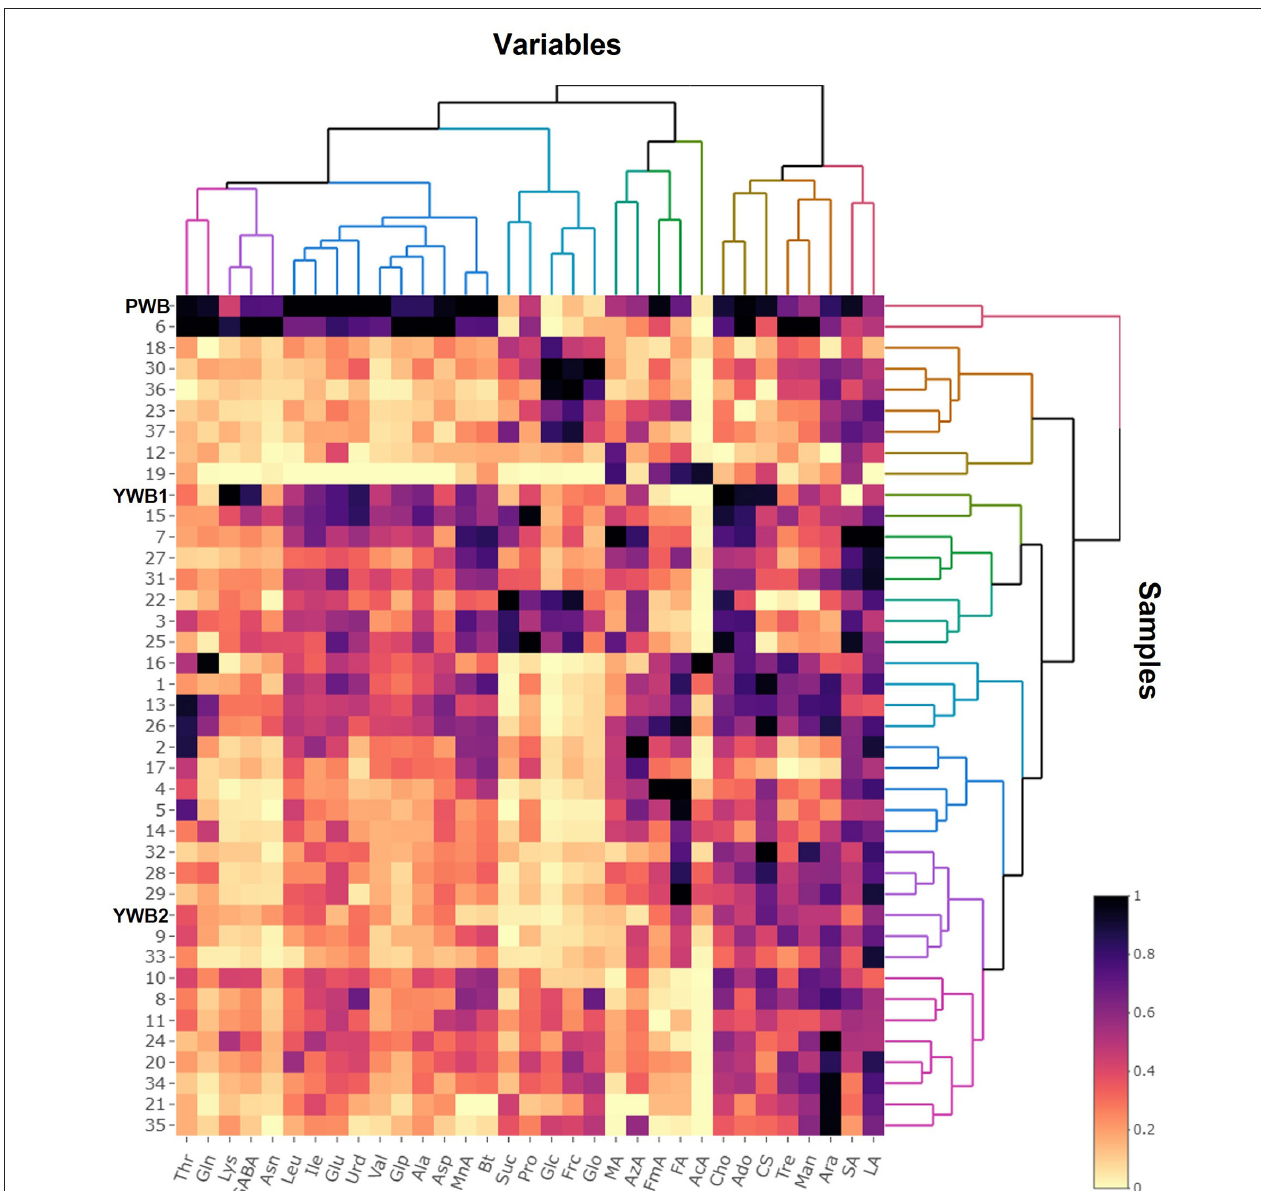
FIGURE 4 | Heat map visualization of the normalized quantification